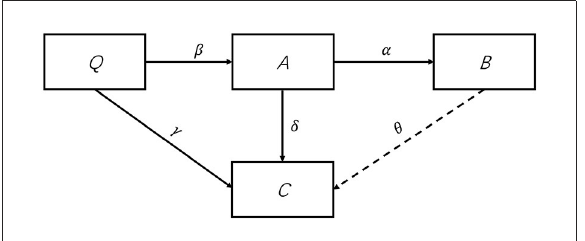
FIGURE1 Flowchart of enterprises in a